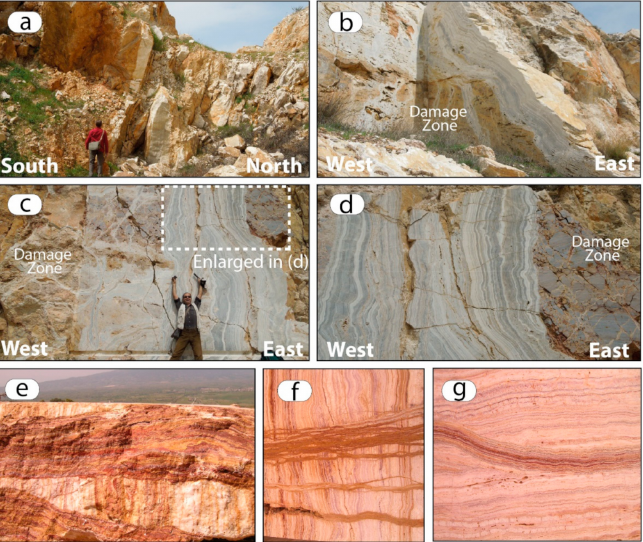
Figure 14. Banded Ca-carbonate veins filling the fracture network of the substratum of a fissure ridge and corresponding to the feeders of the spring. Examples from Golemezli ( a – d ) and Kamara area ( e – g ), Denizli Basin